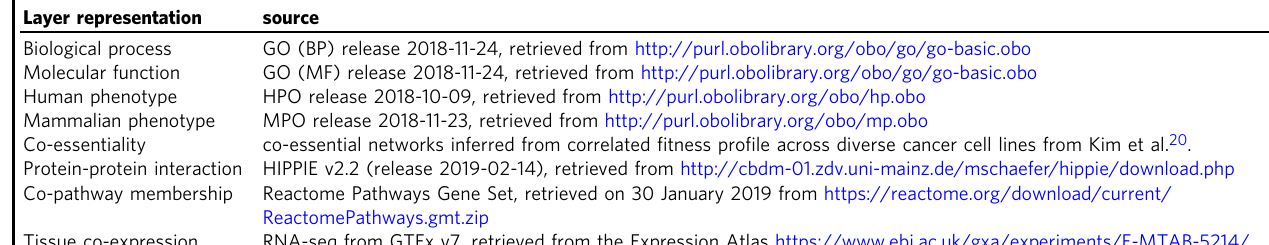
Table 1 Resources used for the multiplex network